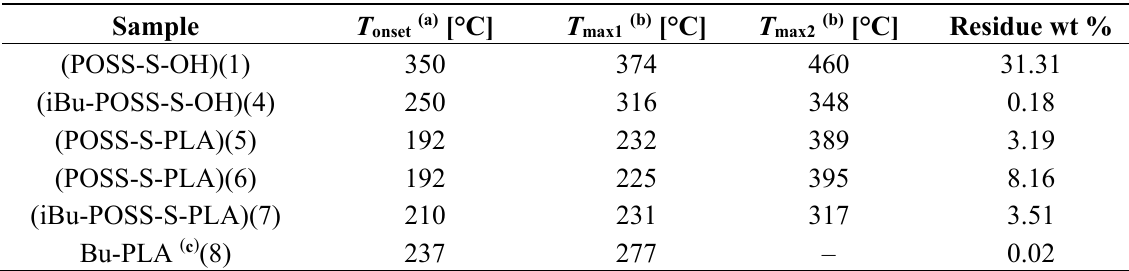
Table 4. Thermal properties of organic-inorganic hybrid and hybrid polymers with POSS